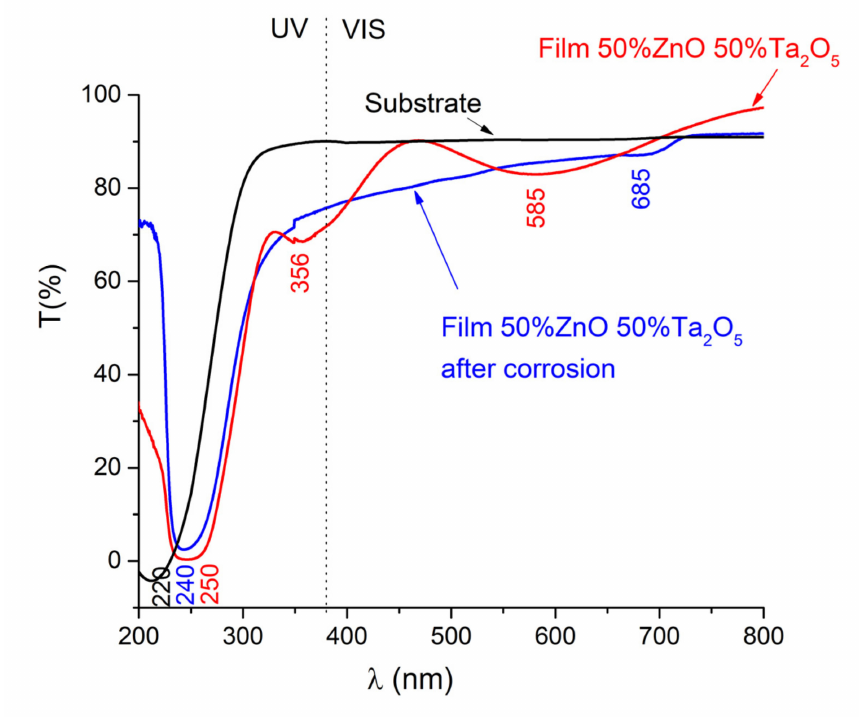
Figure 5. UV-VIS spectra of the substrate and film 50%ZnO50%Ta 2 O 5 before and after corrosion. The optical direct band gap of the thin film is calculated according to the methods outlined in the literature [31,32]. When the thin film is non-crystalline, Tauc plots can be used to determine the optical direct band gap. Figure 6 presents the Tauc plot ( α h ν ) 2 vs. energy (h ν ) for the film before and after corrosion. The band gap value is obtained from the intersection of the tangent of the absorption edge (straight line in the graph) with the x -axis. The formulas used for axes of Tauc plot